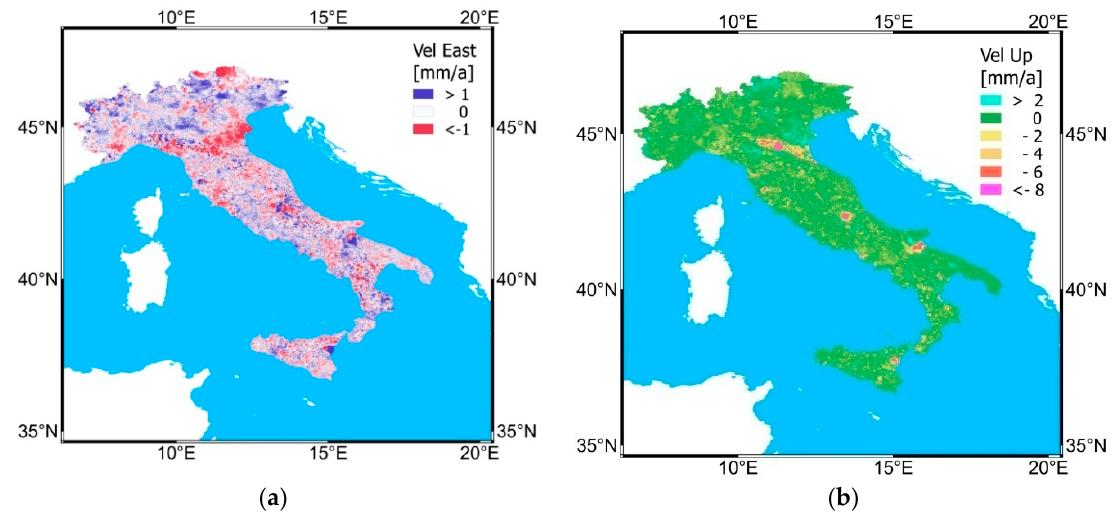
Figure 3. East component ( a ) and the vertical component ( b ) of the surface ground velocity derived by PS radar interferometry determined the combination of ascending and descending LOS velocities.